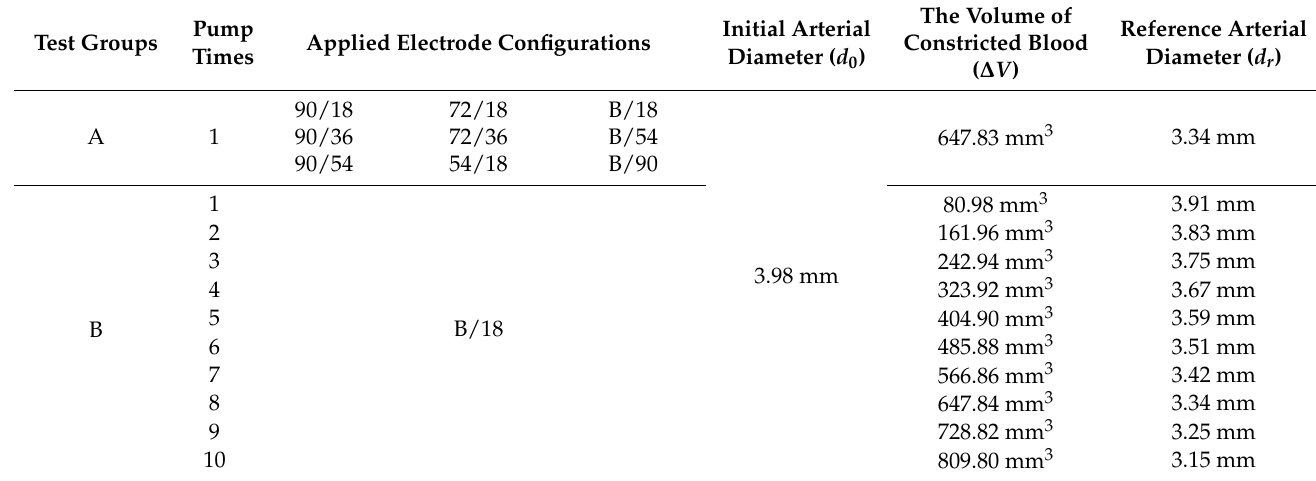
Table 4. Experimental details of each test